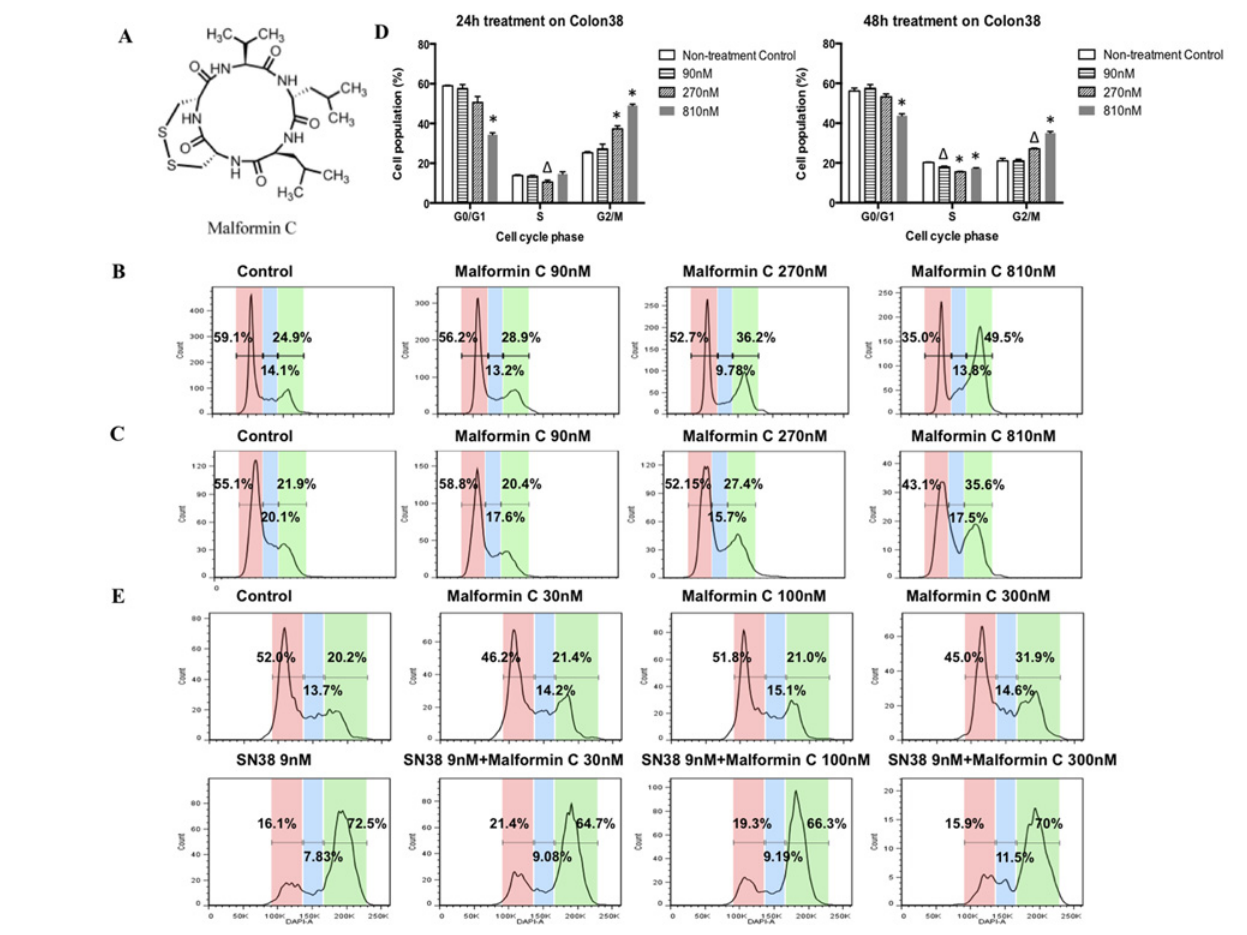
Fig 1. Cell cycle analysis of Colon 38 cells treated by Malformin C and its combinations. (A) Chemical structure of Malformin C. Malformin C is a member of Malformins, a group of fungal cyclic pentapeptides. Its chemical formula is C 23 H 39 O 5 N 5 S 2 with a molecular weight of 529.7. (B) Cell cycle progression of Colon 38 cells exposed to an increasing concentration of Malformin C for 24 hours. (C) Cell cycle progression of Colon 38 cells exposed to an increasing concentration of Malformin C for 48 hours. (D) The dose-dependent accumulation of G2-M phase Colon 38 cells treated by Malformin C at concentrations of 90 nM, 270 nM and 810 nM. Compared to the control group, the symbol Δ represented P < 0.05, while * represented P < 0.01. (E) Cell cycle analysis of Colon 38 cells treated with combinations of Malformin C and SN38. All the cells were exposed to respective compounds indicated above the graph for 24 hours and the analysis was done in duplicate. When treated with SN38, no significant changes of cell cycle progression were observed without or with different dosage of Malformin C.